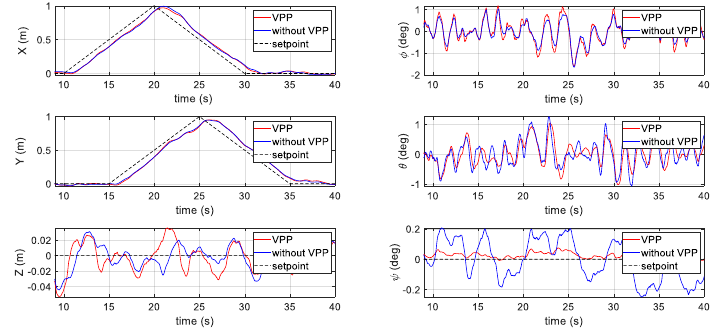
Figure 9. Results of the third scenario in the simulation.